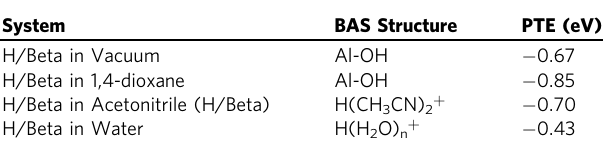
Table 3 Proton transfer energy (PTE) to pyridine in H/beta in